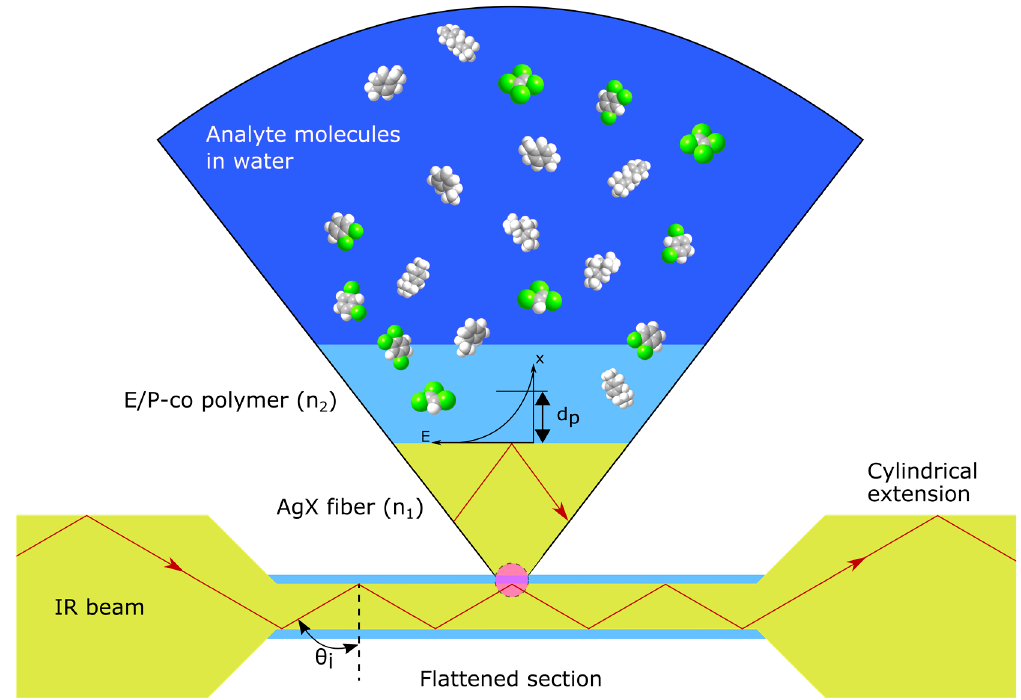
Figure 1. Schematic attenuated total reflection principle of an E / P-co polymer coated AgX fiber. The number of total internal reflections is increased within the flattened section of the AgX fiber. Analyte molecules in an aqueous solution (dark blue) enrich into the polymer layer (light blue) and are detected within the penetration depth d p of the exponentially decaying evanescent field. θ i is the angle of incident light, n 1 and n 2 are the refractive indices of the AgX fiber and E / P-co polymer, respectively, E is the intensity of the evanescent field depending on the distance x .